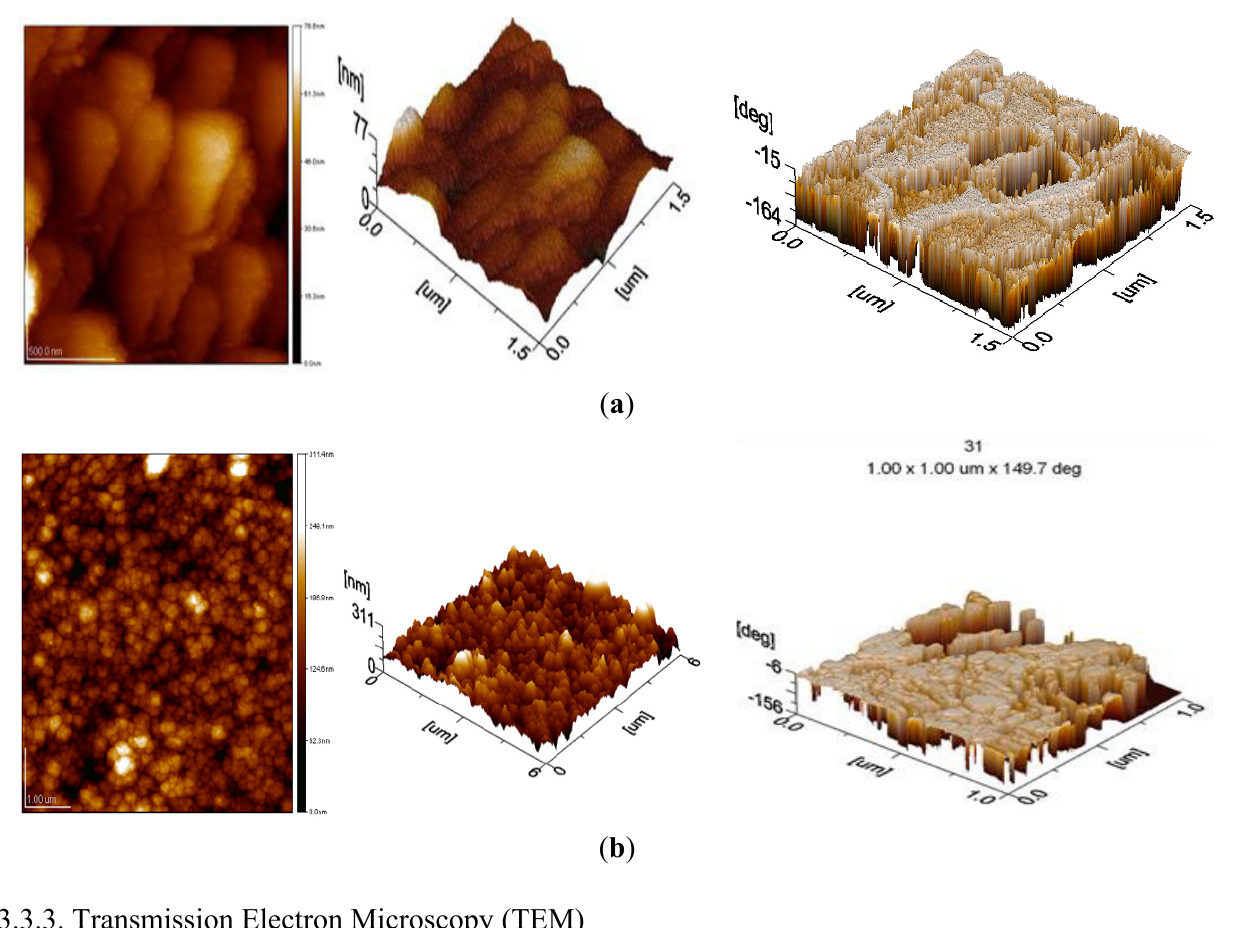
Figure 7. Typical 2D- and 3D-Atomic Force Microscopy (AFM) images of ( a ) electrodeposited (ED)-CdS and ( b ) ED-CdTe surfaces. 2D-images show presence of large clusters and 3D-images show their fine